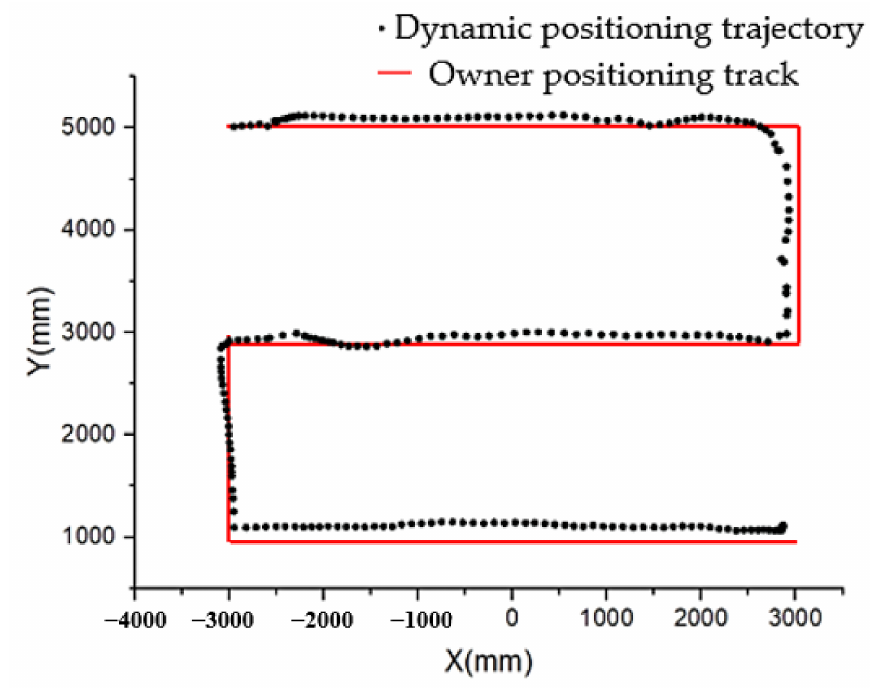
Figure 6. Dynamic positioning trajectory.